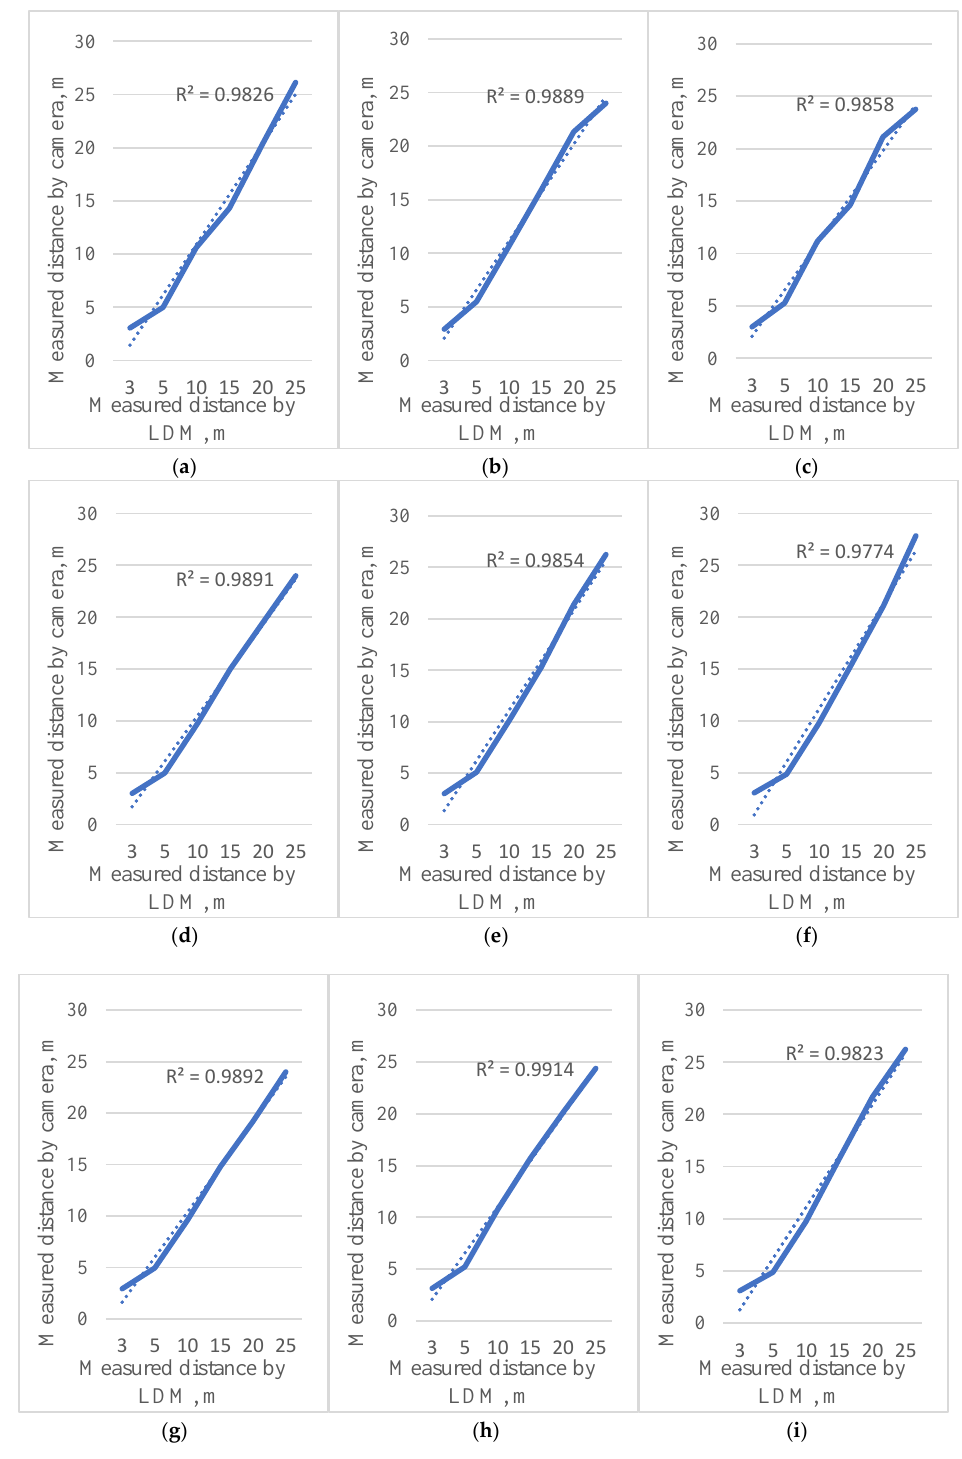
Figure 7. Measured distance under different lighting and orientations. ( a – c ) 0°, −30°, and 30° under high-light condition; ( d – f ) 0°, −30°, and 30° under low-light condition; ( g – i ) 0°, −30°, and 30° under no-light condition.